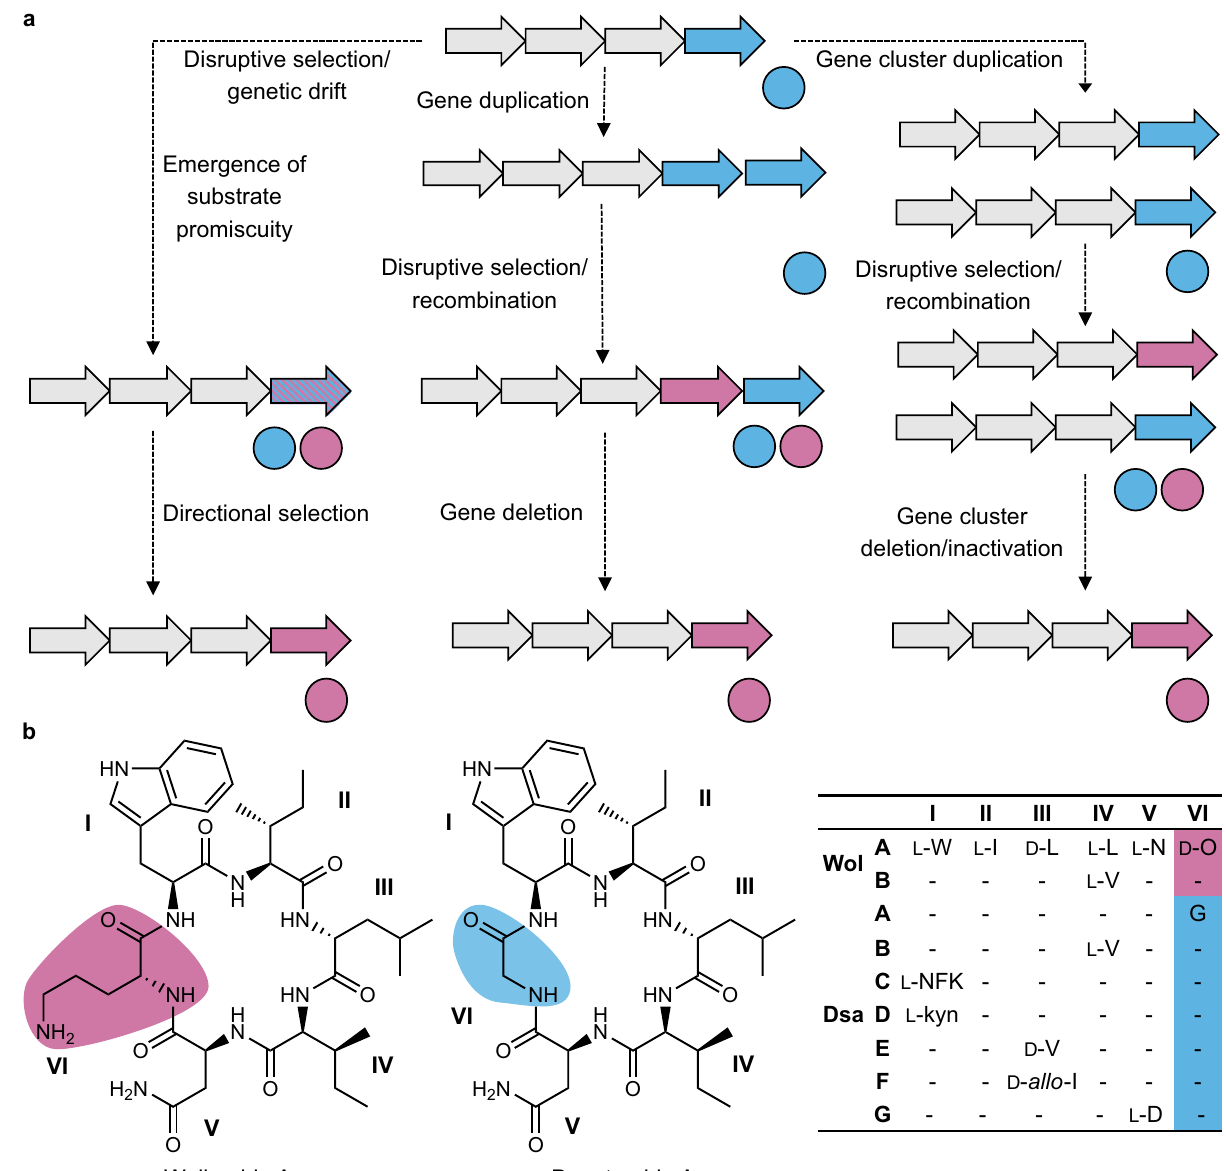
Fig. 1 Intermediate chemotypes in the evolution of natural product biosynthetic gene clusters (BGCs). a A cartoon demonstrating the three main models of gene cluster evolution depicting the transition of a fi ctitious BGC from chemotype A to chemotype B (coloured circles). Evolutionary processes are represented by dashed lines. b The structural diversity of the wollamides and desotamides. The D -ornithine and glycine residues, which de fi ne the wollamides and desotamides, respectively, are highlighted. The table on the right-hand side shows the variable positions of the various wollamide and desotamide congeners (NFK N-formyl kyunerine, Wol wollamide, Dsa